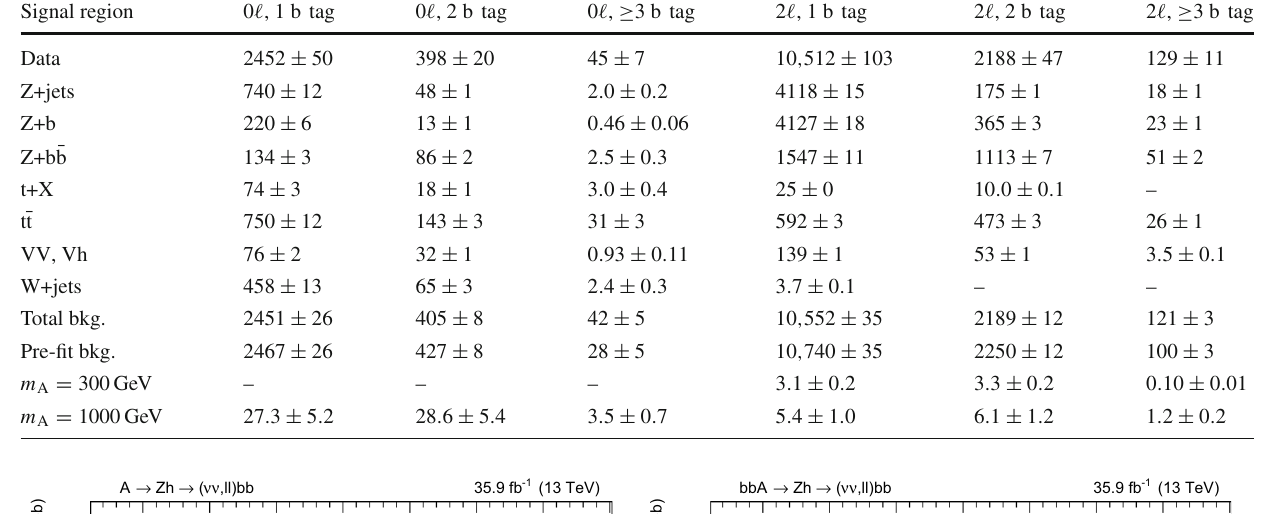
Table 4 Expected and observed event yields after the fit in the signal regions. The dielectron and dimuon categories are summed together. The “–” symbol represents backgrounds with no simulated events pass- ing the selections. The signal yields refer to pre-fit values correspond-